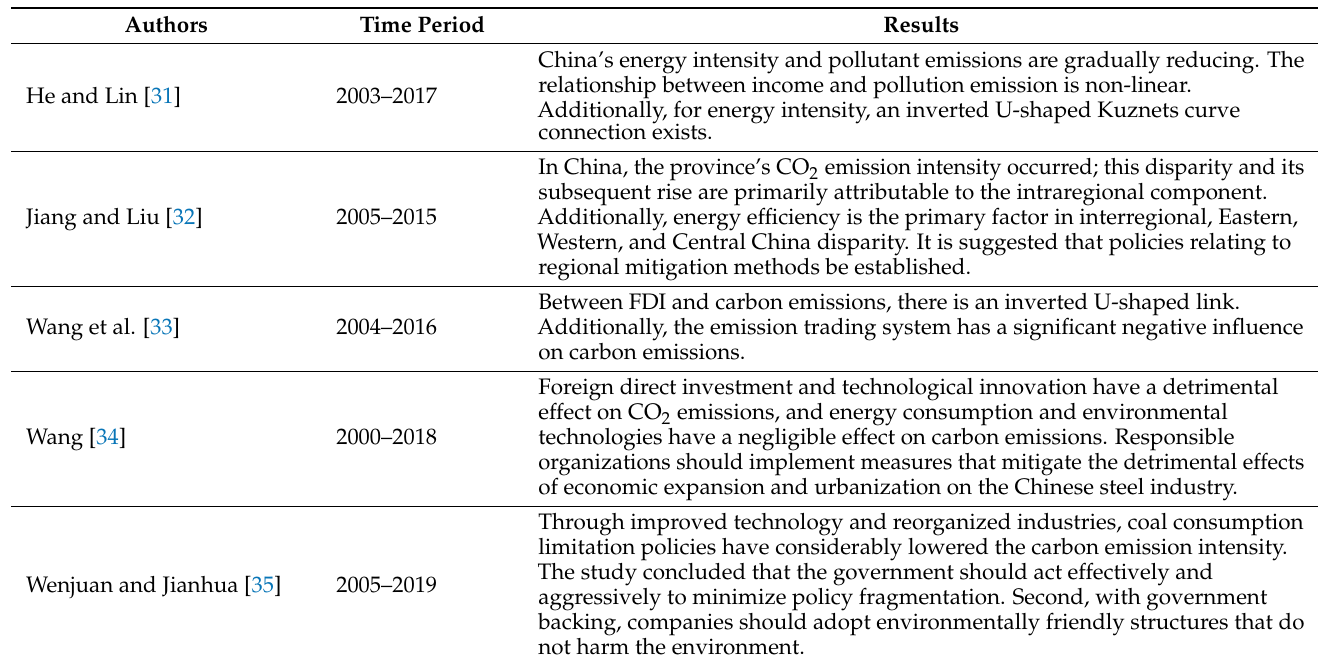
Table 1. Literature Review on Environmental Sustainability